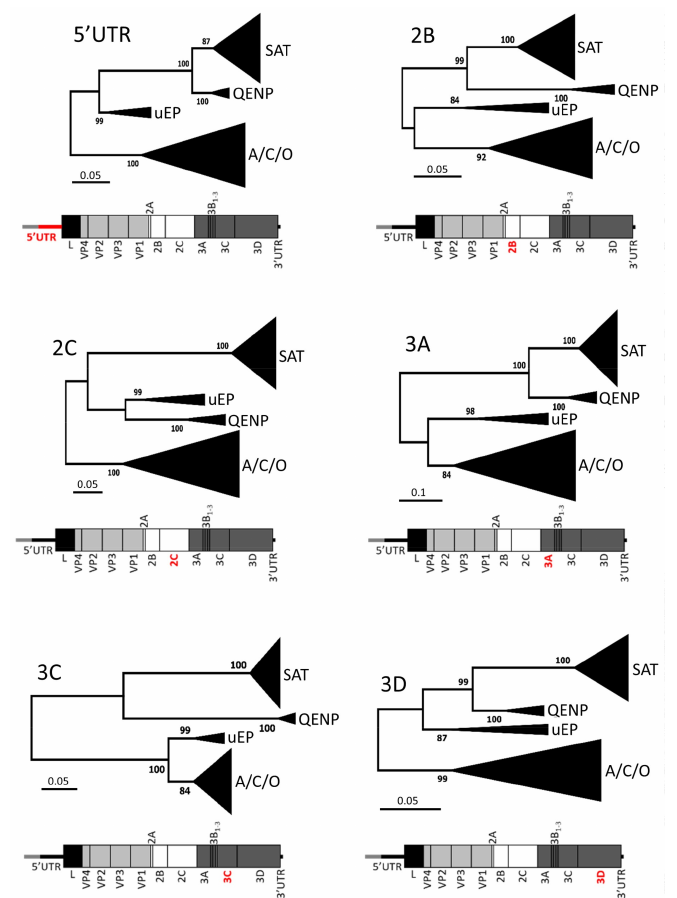
Figure 3. Distinct clustering for QENP and uEA isolates is displayed for different parts of the genome. The evolutionary history based on six genomic fragments (residual 5 (cid:48) UTR, 2B, 2C, 3A, 3C and 3D) was inferred using the ML method and GTR + G + I nucleotide substitution model (both implemented in MEGA7 software). For each fragment, the tree with the highest log likelihood is shown. The percentage of trees (with the 60% cut-off) in which the associated taxa clustered together is shown next to the branches. Initial tree for the heuristic search were obtained automatically by applying NJ and BioNJ algorithms. A schematic drawing of the FMDV genome highlighting (in red) investigated genomic region is shown under each associated